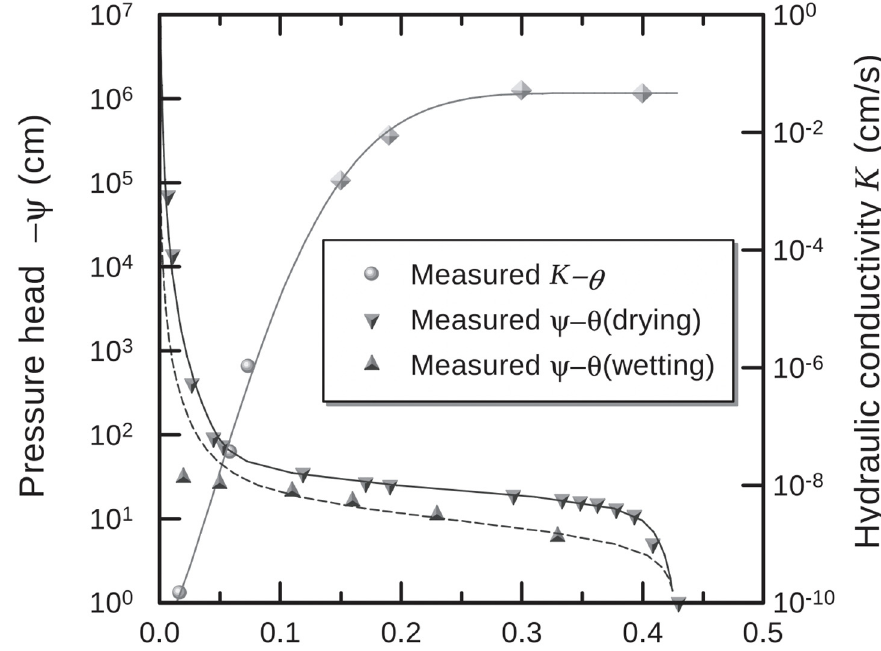
Figure 2. Hydraulic properties of Tottori sand in the experiment site.